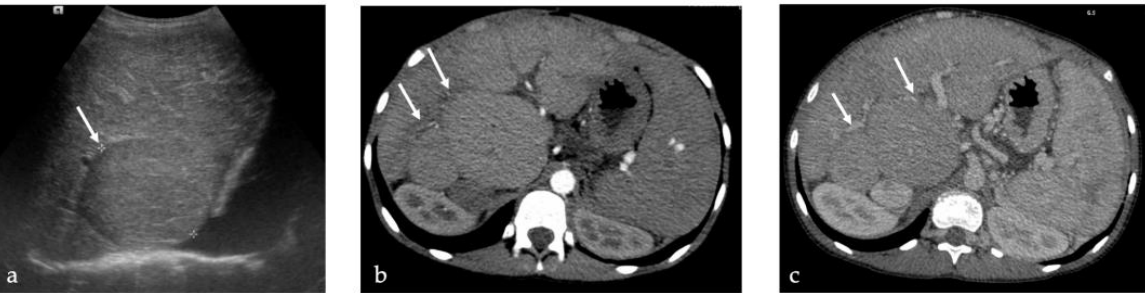
Figure 1. Macroregenerative nodules in a 14-years old boy with biliary atresia. US ( a ) with large isoechoic nodules with no vascularization on Doppler. CT with arterial ( b ) and venous ( c ) acquisition: multiple diffuse isodense iso-enhancing nodules.